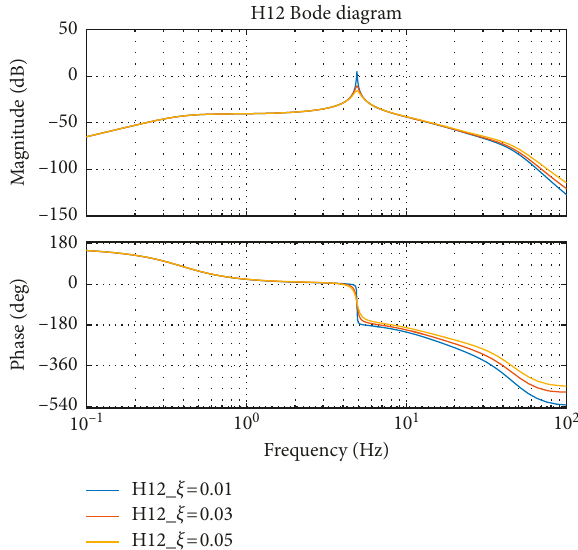
Figure 8: Effect of specimen’s damping ratio on frequency re- sponse of H 12 .